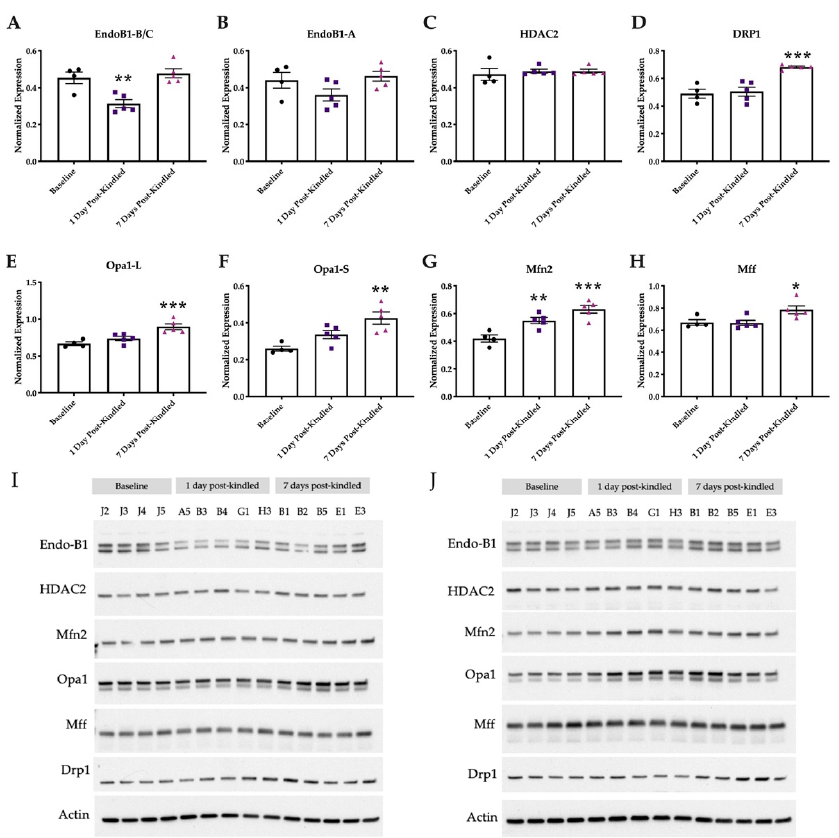
Figure 7. Male mice demonstrate evidence of dynamic changes in mitochondrial membrane integrity-associated protein expression within isolated hippocampus following induction of the corneally kindled model of acquired temporal lobe epilepsy. Left and right hippocampal tissues were micro-dissected at baseline prior to kindling or 1 or 7 days after acquisition of the fully kindled state. ( A ) Expression of the mitochondrial protein Endo-B1-B/C isoform (neuron specific) was significantly reduced 1 day after acquisition of the fully kindled state but returned to baseline levels by 7 days post-kindling. ( B ) Expression of the mitochondrial protein Endo-B1-A isoform (ubiquitous) was not significantly reduced by corneal kindling. ( C ) Expression of HDAC2, which modulates Endo-B1 expression, was not significantly affected by corneal kindling. ( D ) Expression of Drp1, a mitochondrial GTPase, was significantly elevated 7 days after acquisition of the fully kindled state. Drp1 recruitment to mitochondria is necessary and sufficient for mitochondrial fission in periods of cellular stress. ( E ) Expressions of OPA-1 long (OPA1-L) and OPA-1 short (OPA1-S) on the inner mitochondrial membrane with mitofusin 2 (MFN2) on the mitochondrial outer membrane are critical to the maintenance of fusion-competent mitochondria under periods of cellular stress. Expression of the OPA1-L isoform was significantly elevated 7 days after acquisition of the fully kindled state. ( F ) Expression of the OPA1-S isoform was significantly elevated 7 days after acquisition of the fully kindled state. ( G ) Expression of mitofusin (MFN2) was significantly elevated by kindling in general, showing robust increases at both 1 day and 7 days post-kindling acquisition. ( H ) Expression of mitochondrial fission factor (Mff) was significantly elevated 7-days post kindling acquisition. All data are presented as the mean of bands from the left and right hippocampus for all mice in each experimental group, with +/ − S.E.M. and all statistical analysis conducted by one-way ANOVA; * indicates p < 0.05, ** indicates p < 0.01, and *** indicates p < 0.001. ( I ) Immunoblot image of micro-dissected right hippocampus. All protein bands of interest were normalized against β -actin values within the same blot. Animal IDs are listed above each corresponding protein lane. ( J ) Immunoblot image of micro-dissected left hippocampus. All protein bands of interest were normalized against β -actin values within the same blot. Animal IDs are listed above each corresponding protein